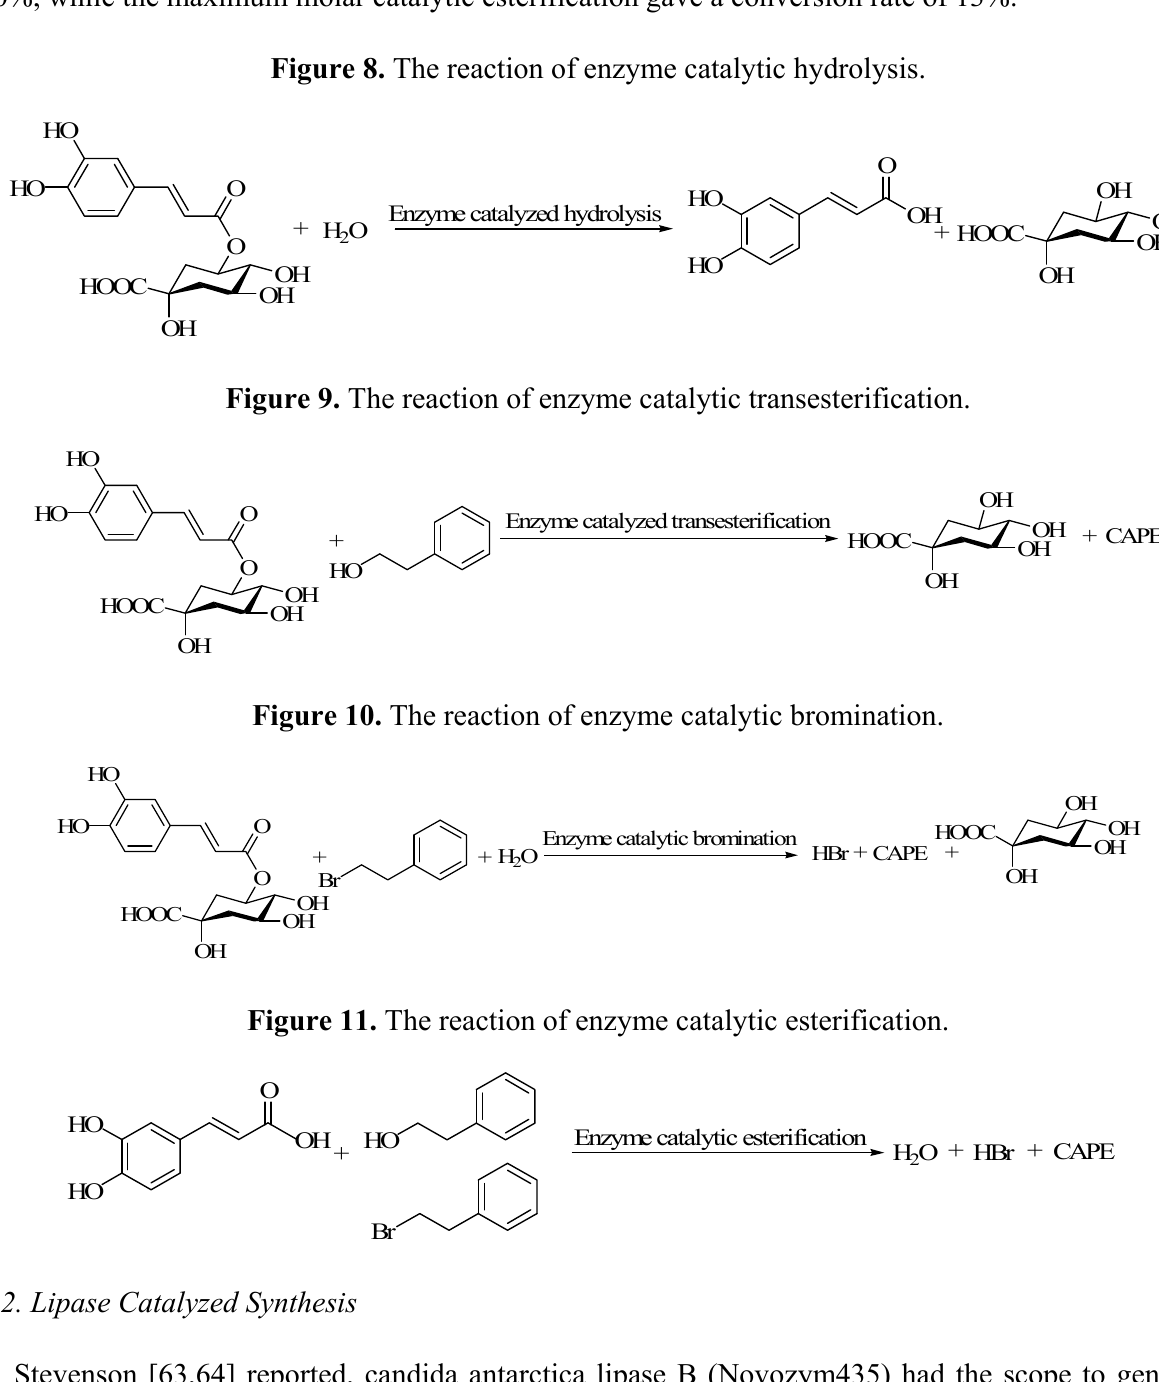
Figure 8. The reaction of enzyme catalytic hydrolysis.